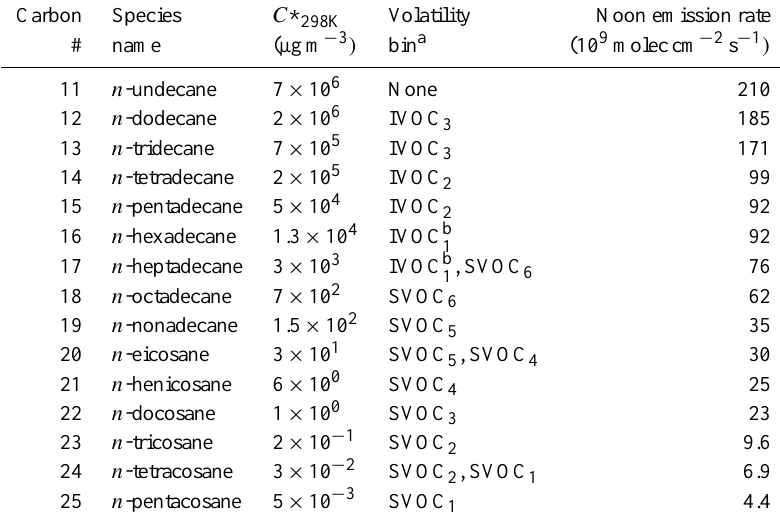
Table 3. Assignment of emissions of longer-chain n -alkanes used as surrogates for all unmeasured NMHCs.